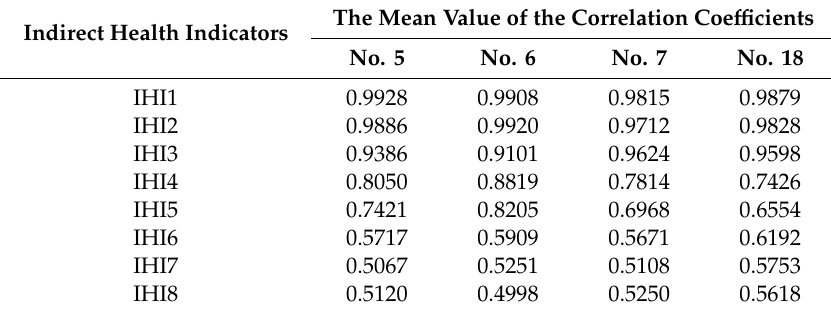
Table 1. Grey relation grades between IHIs and the battery